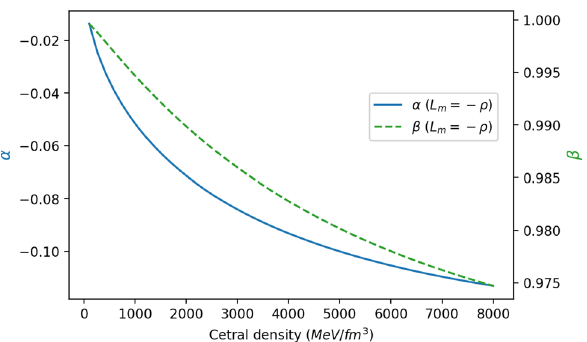
Fig. 3 Values of the parameters α and β in Eqs. (23–26) with respect to the density of the compact object for L m = − ρ